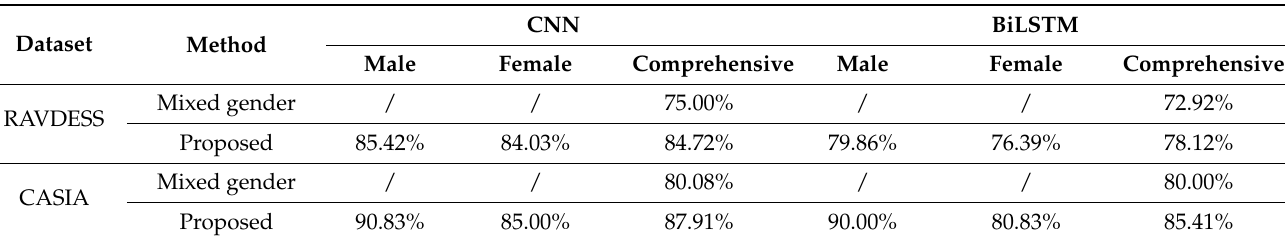
Table 3. Results of speech emotion